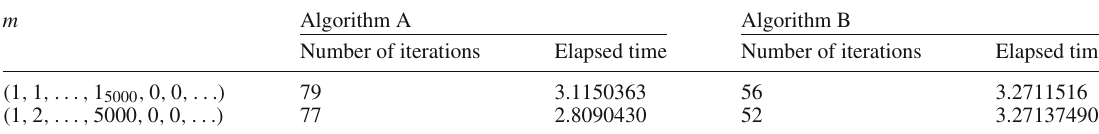
Table 8 Numerical values for Figs. 5, 6, 7 and 8 m Algorithm C Algorithm D Number of iterations Elapsed time Number of iterations Elapsed